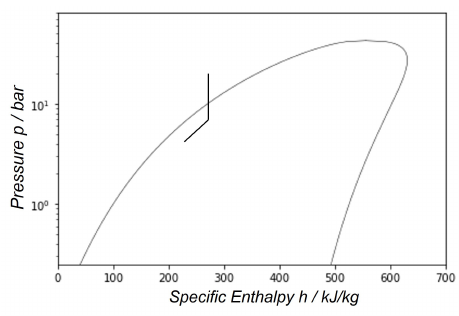
Figure 5. P-h diagram of the behaviour of the fluid inside the capillary tube when the adiabatic stroke length is longer than single-phase length.